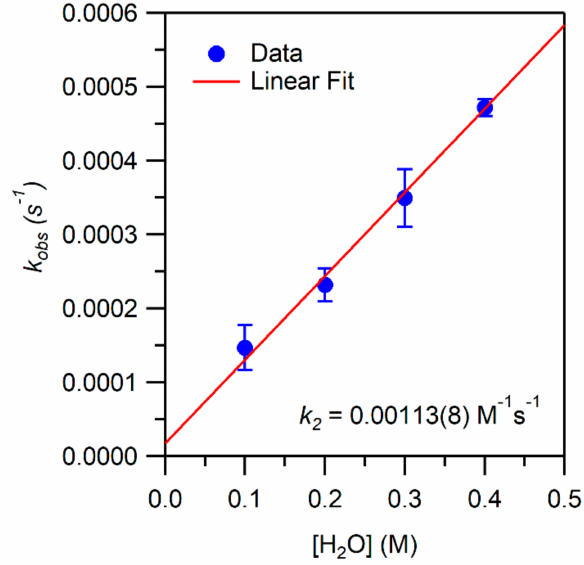
Figure 10. Pseudo-first-order rate constants k obs (s − 1 ) as a function of H 2 O concentration for an anaerobic solution of 1 mM [Mn III (OO tBu )( 6Me dpaq)] + in MeCN at 25 ◦ C. The second-order rate